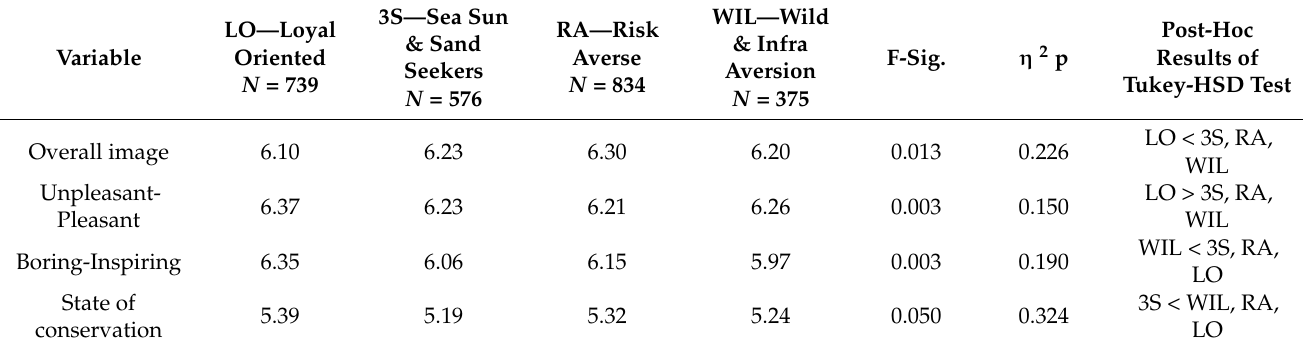
Table 6. Cluster differences based on islands’ perceived image and state of